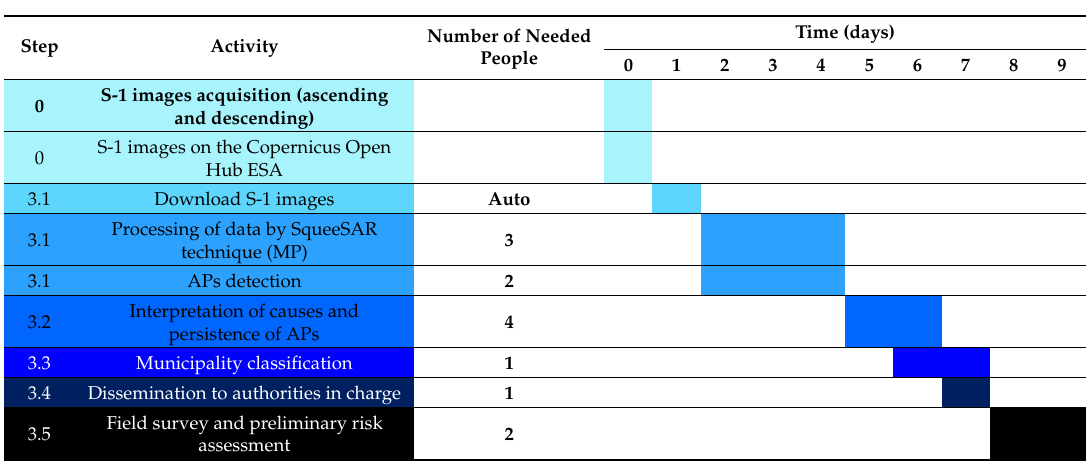
Figure 8. Multi-temporal bulletins delivered during the project ( a ) and all the “red” municipalities reported during the two years of continuous monitoring ( b ). Table 5. Timesheet for the proposed